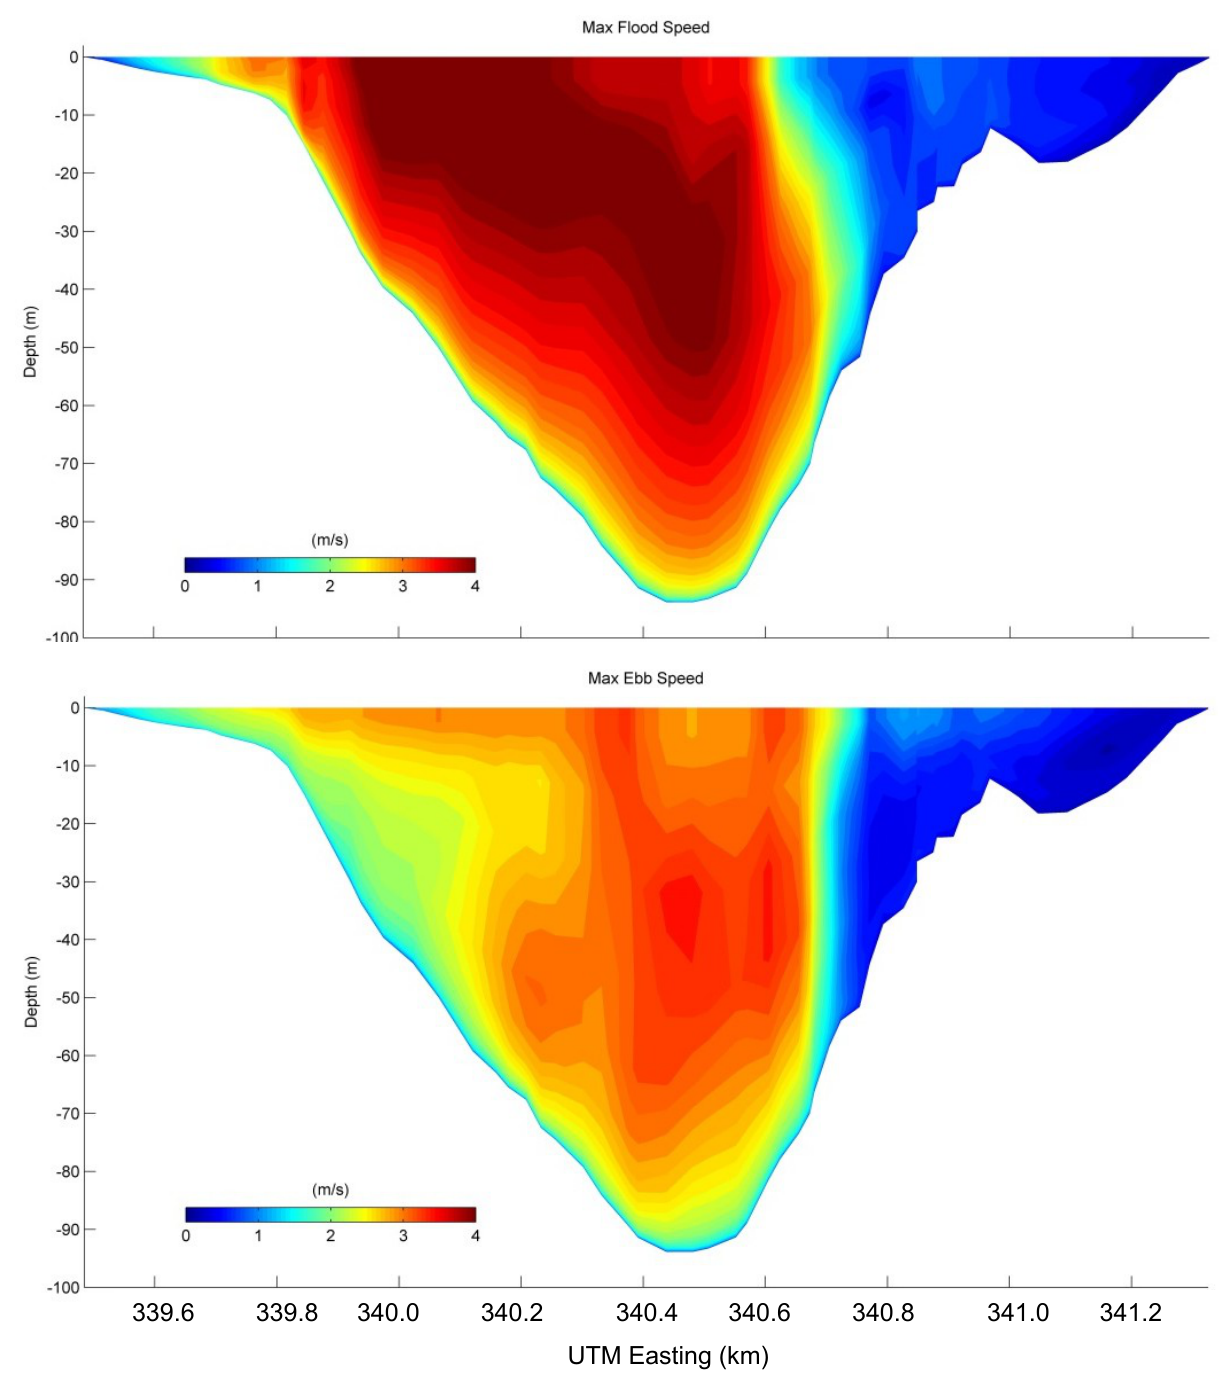
Figure 9. Vertical distribution of model derived maximum current speeds along the routes during flood (upper panel) and ebb (bottom panel)